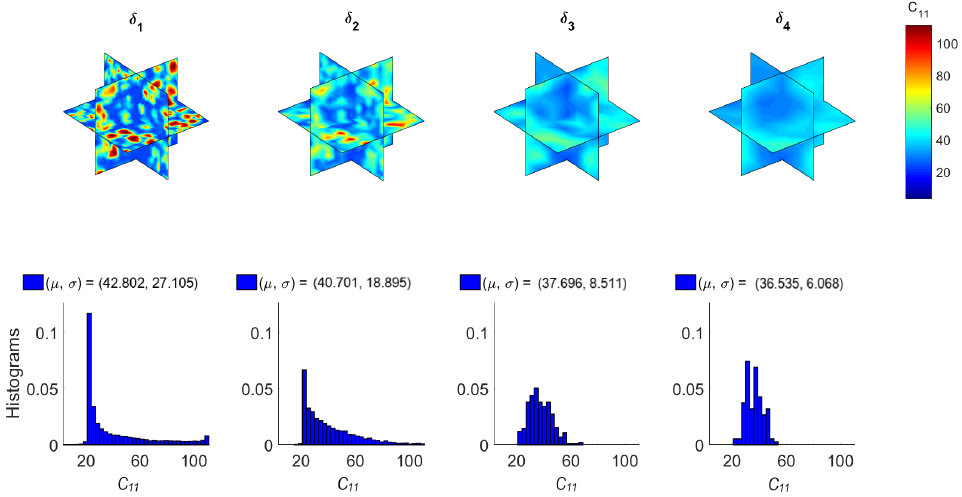
Figure 6. Random fields and histograms of ¯ C 11